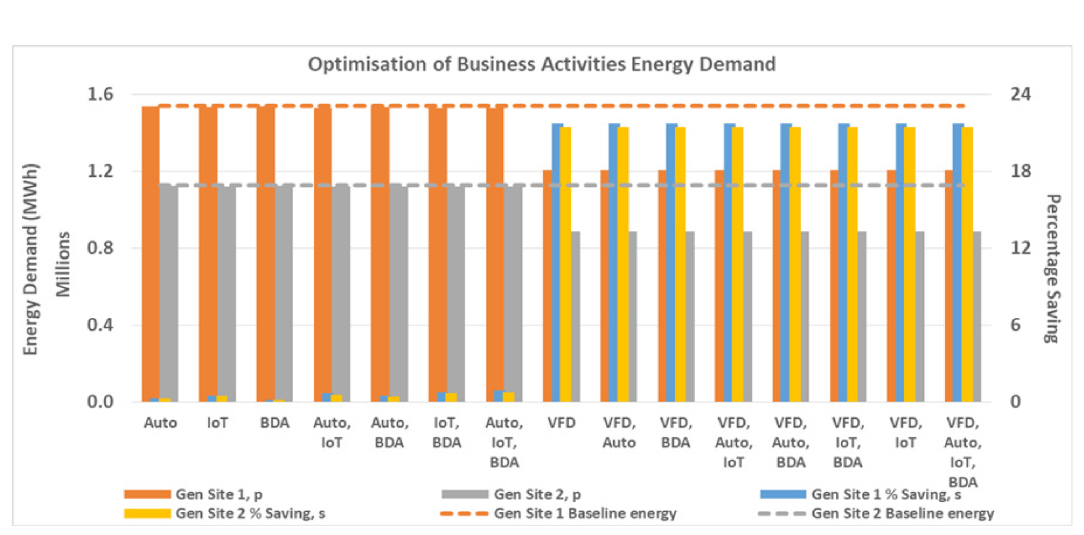
Figure 10. Impact of optimization technologies on electrical energy